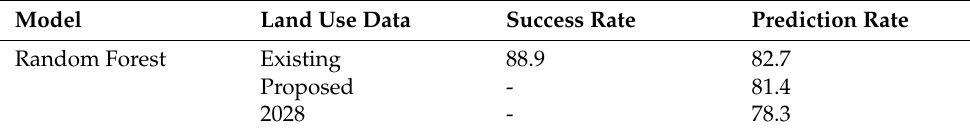
Table 6. Success and prediction rates of random forest